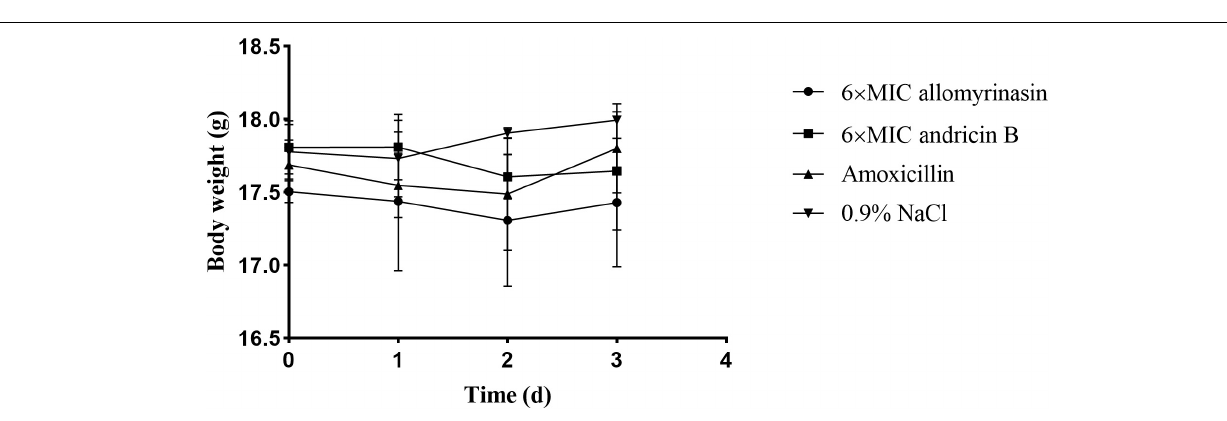
from 32 to 64, 64 to 256, and 0.5 to 8 µ g/ml, respectively.